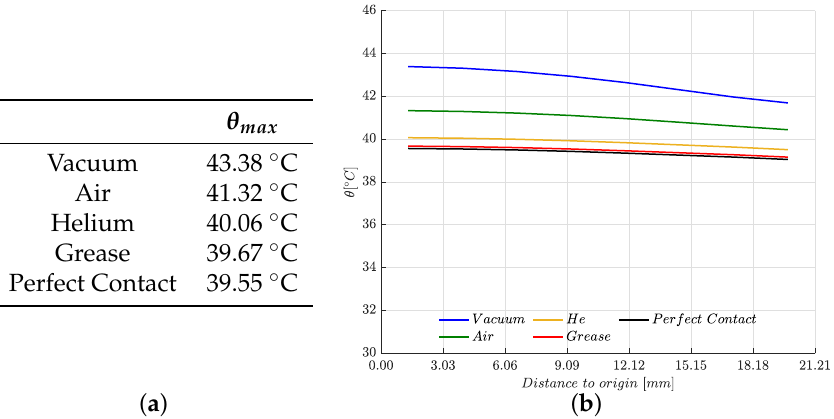
Figure 16. ( a ) Maximum temperature values comparison on the base of the microprocessor for each TIM analyzed. ( b ) Temperature distribution comparison at the nodes located at the diagonal of the base of the microprocessor.